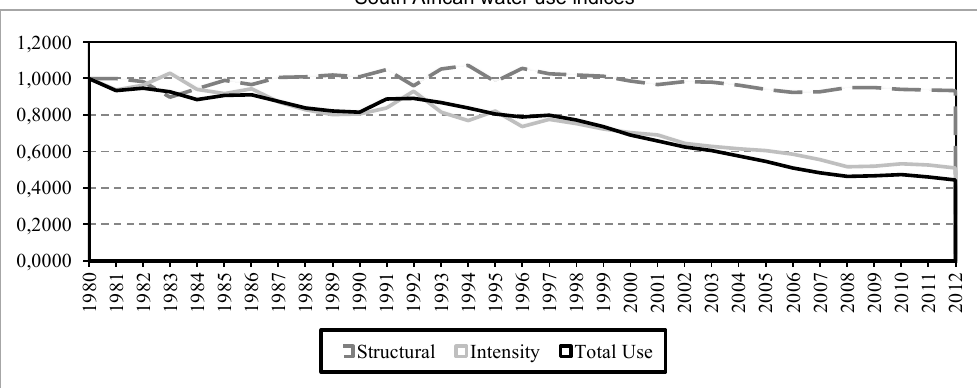
Figure 3 South African water use